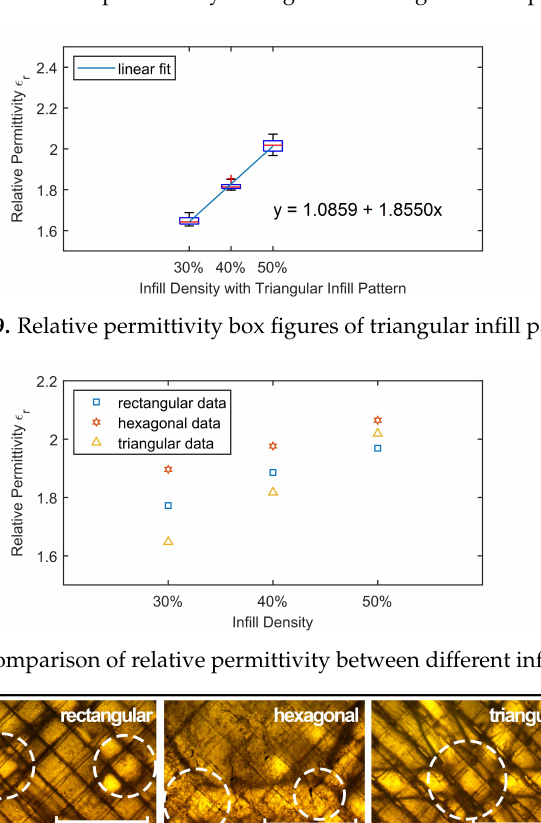
Figure 8. Relative permittivity box figures of hexagonal infill pattern.